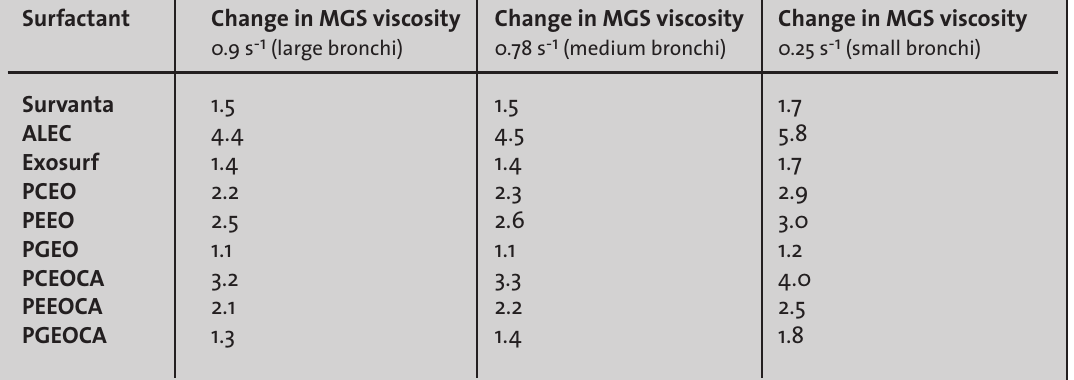
Table 3: Ratio of change in MGS viscosity at shear rates of physiologic